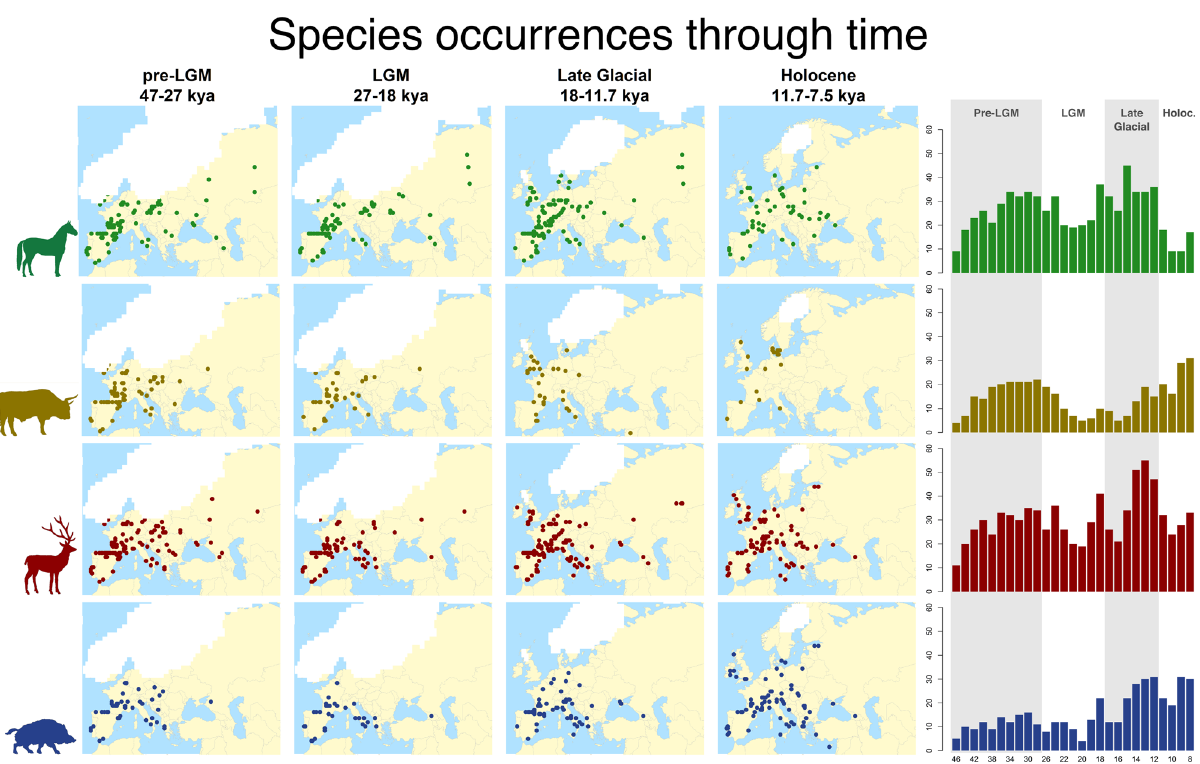
Fig. 2 Geographic and temporal distribution of horse, aurochs, deer, and wild boar occurrences. Dates are expressed in thousands of calibrated years before present